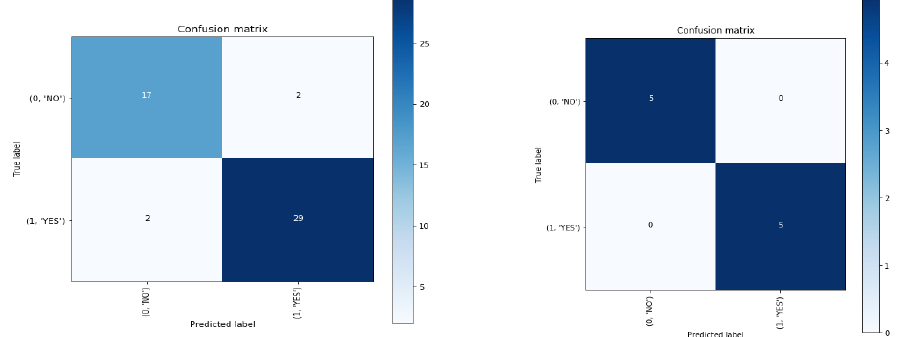
Figure 2. Four different regions (confusion matrix) to provide the extraction of ML model’s feature vector.